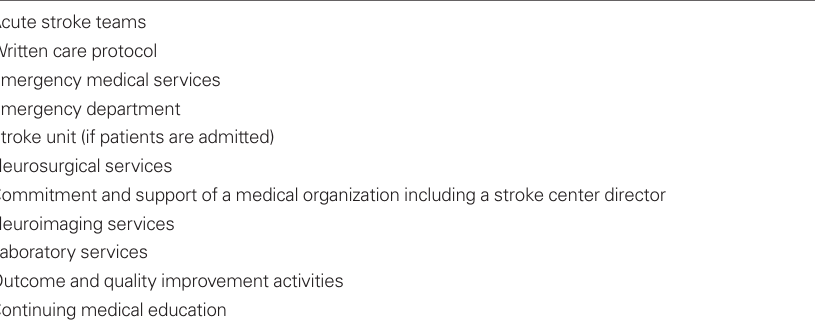
Table 1 | Major elements of a primary stroke center or PSC (Alberts et al., 2000).